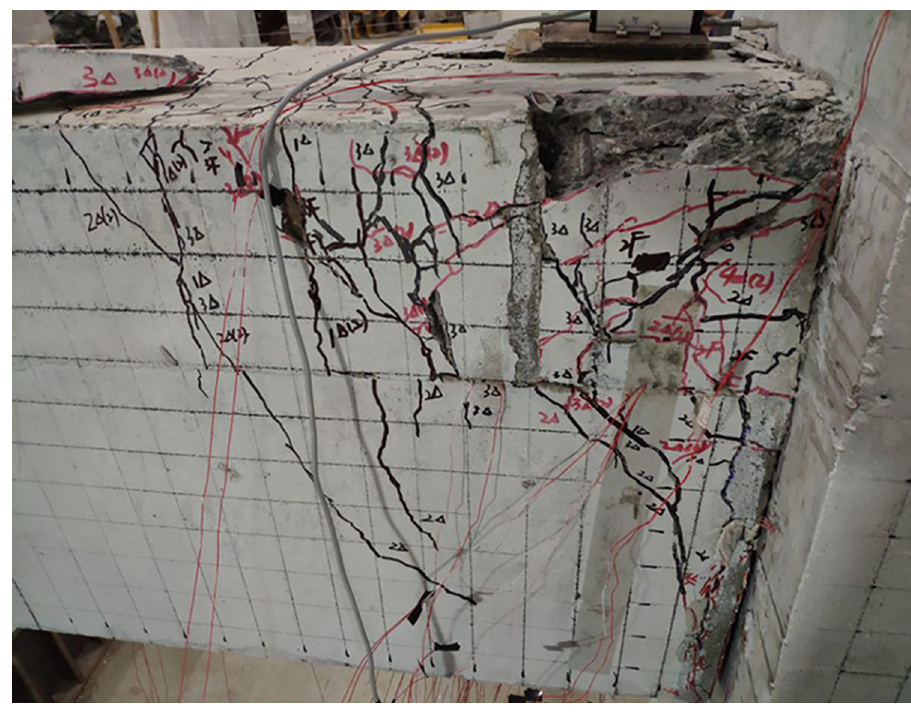
Fig 11. Failure mode of SJ-2.